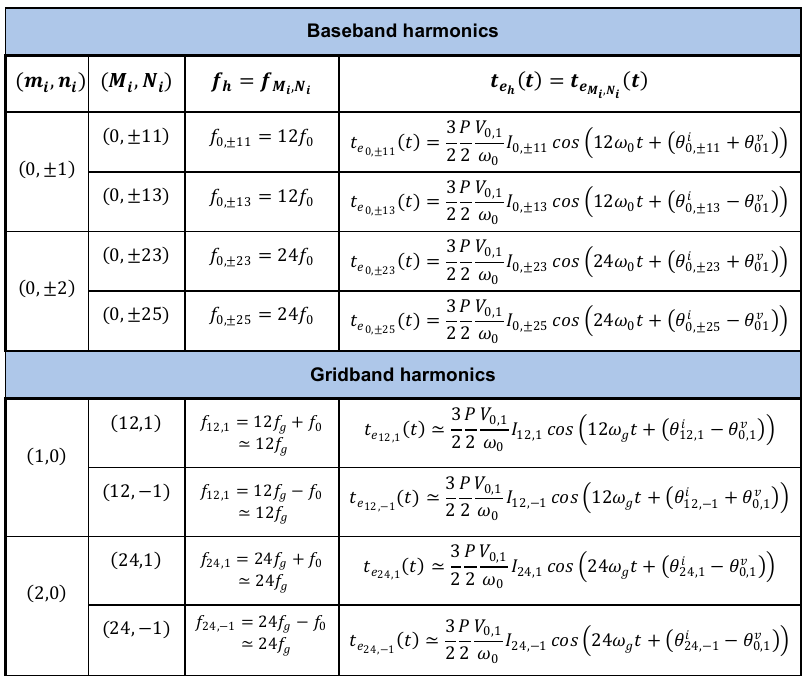
Figure 6. Harmonic families in a 6/6-pulse LCI system: sideband families.